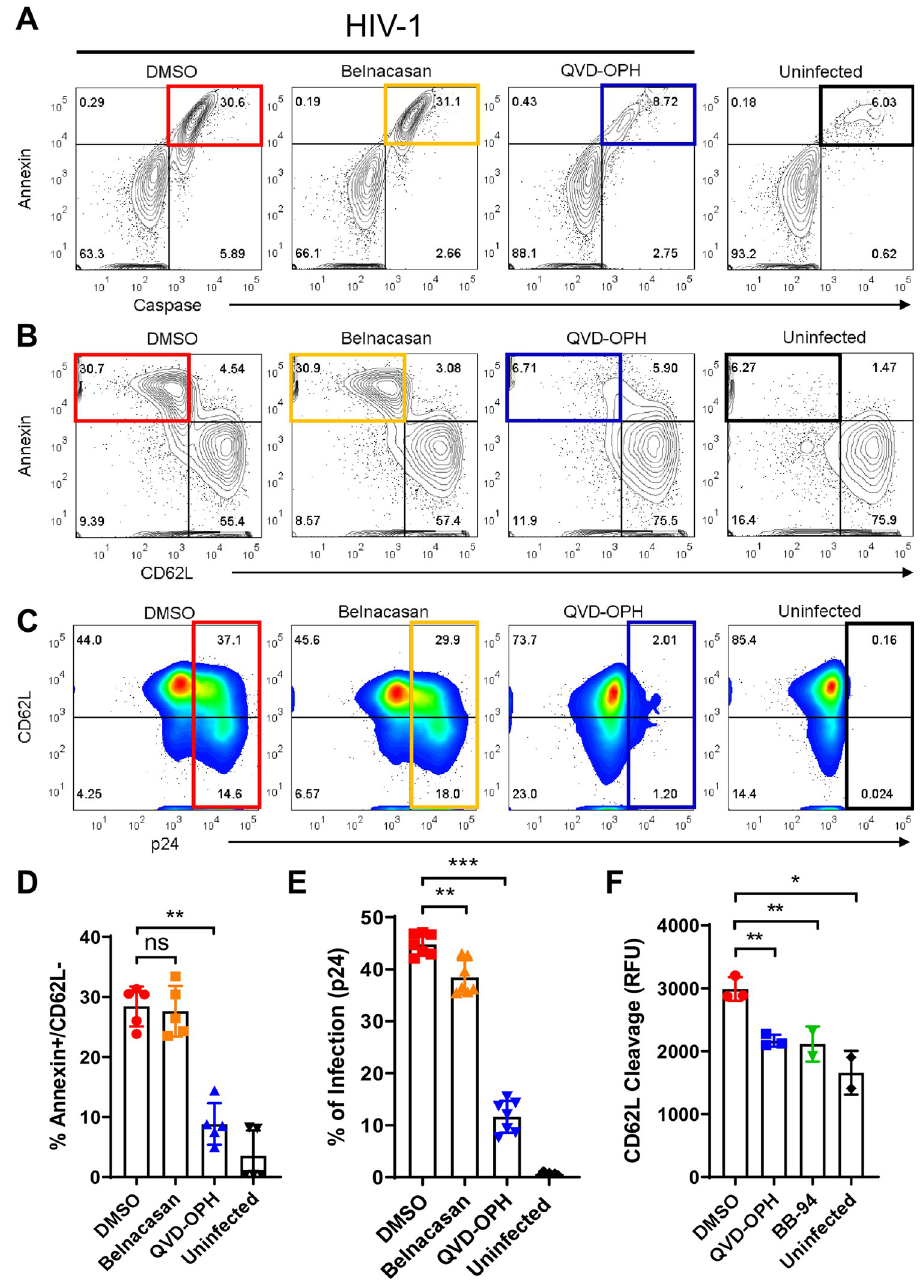
Fig 2. Caspase activation results in phosphatidylserine exposure and loss of CD62L expression in infected T cells. (A-C) Representative FACS contour plots on day 6 HIV-1 BAL infected PBMC stained with anti-p24 antibody, annexin V, fluorescent inhibitor of caspases (FLICA), and anti-CD62L antibody. The populations exhibiting caspase+/annexin V+ (A) and annexin V+/CD62L- (B) are highlighted in colored quadrants. QVD-OPH (blue gates) but not Belnacasan (orange gates) inhibited caspase activation ( A ), CD62L loss ( B ) and the viral infection (C) . Histograms corresponding to the FACS data presented in panels A and B are shown in S3E Fig for the caspases and CD62L expressions as well as annexin V staining in the infected and uninfected T cells. (D, E) Quantification of the populations in panels B and C . (F) On cell enzymatic cleavage of a fluorogenic CD62L peptide by HIV-1 BAL infected and uninfected PBMC in the presence of QVD-OPH, BB-94 or control DMSO. Data are representative of three independent experiments and statistics are shown as Mann-Whitney nonparametric test � p < 0.05, �� p < 0.01.